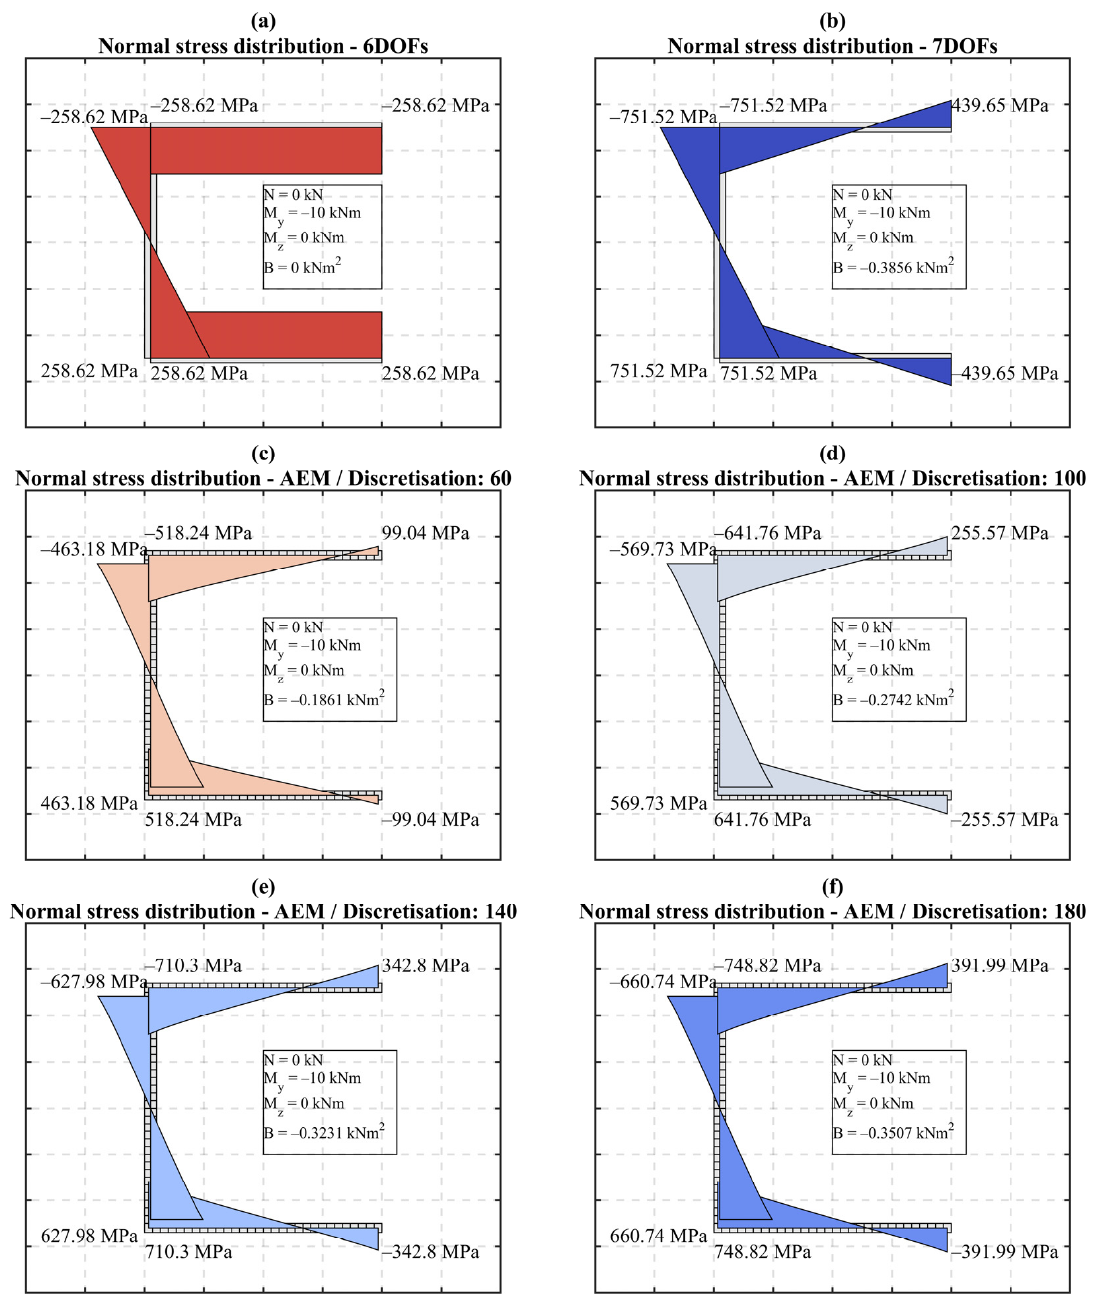
Figure 8. Normal stress distribution for Section #2, with a length L = 1000 mm and a section discretisation of 30 blocks for each section part.